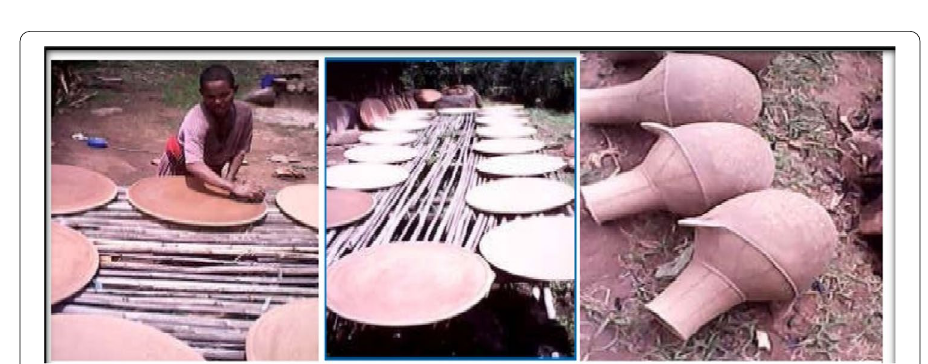
Fig. 2 Potter with griddles and pots manufactured for sale, taken from Quarit and Debre Elias